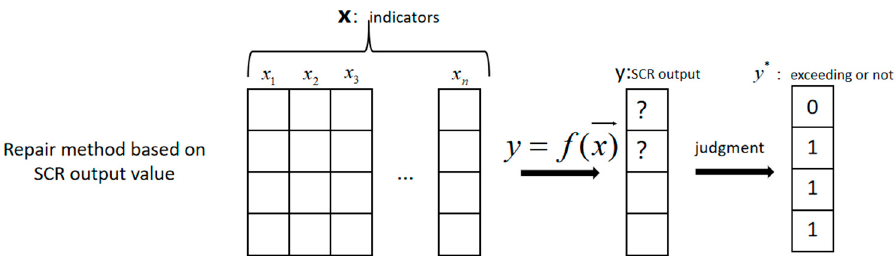
Figure 4. Identification of excessive emissions by imputing missing values for the SCR output based on the other parameters (“?” indicates missing values, “1” and “0” denote excessive emission or not, and y * is a binary variable indicating whether emission exceeds).